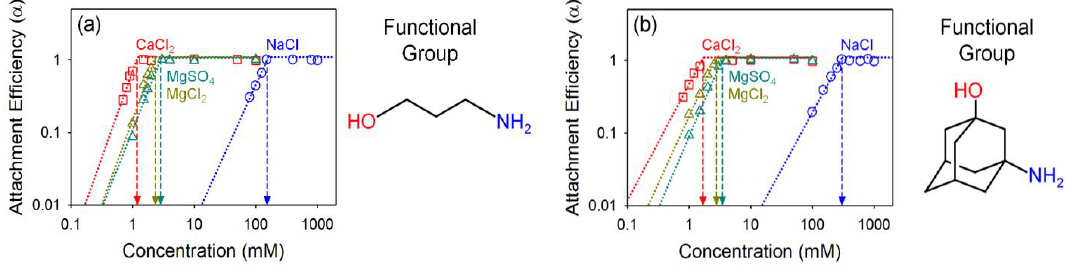
Figure 6. Attachment efficiency of ( a ) 3-amino-1-propanol GO, and ( b ) 3-amino-a-adamantanol GO as a function of salt concentration; NaCl (blue), CaCl 2 (red), MgCl 2 (dark yellow), and MgSO 4 (dark green).